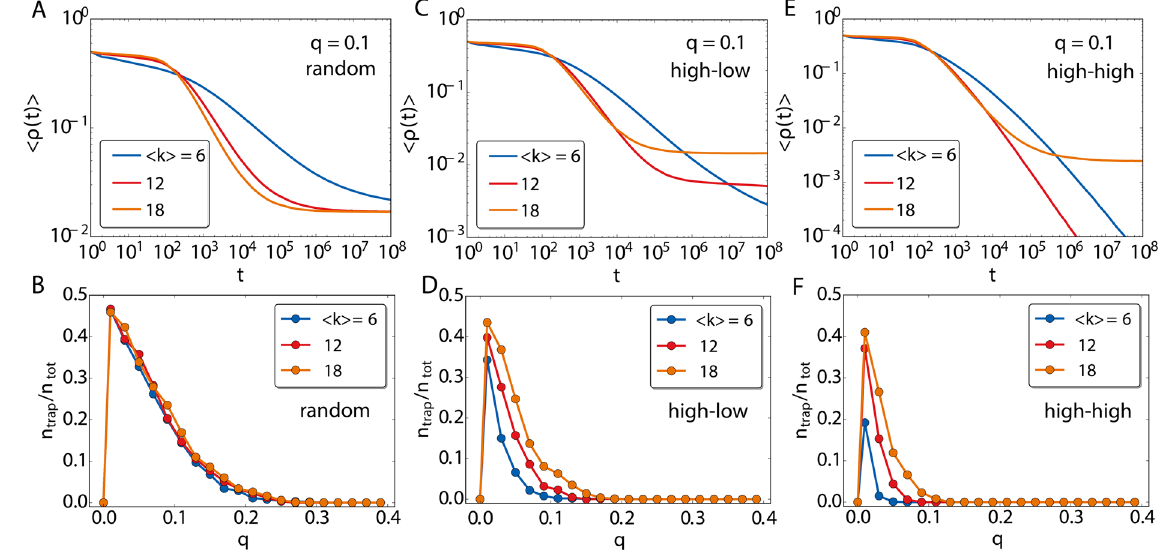
Figure 7. In ( A , C , E ) average fraction of active links as a function of time for different values of 〈 k 〉 with q = 0.1. In ( A ) the interlayer node connections are set at random, regardless of the node degrees, while in ( C ) the nodes are connected following a high-low degree order and in ( E ) following the opposite high-high order. In ( B , D , F ) the corresponding diagrams with the fraction of realizations falling in the trapping states as a function of q . The network topology within each layer is scale free with degree distribution ∼ − . P k k ( ) 2 5 . The network sizes are N = 2000 and ρ is averaged over 1000